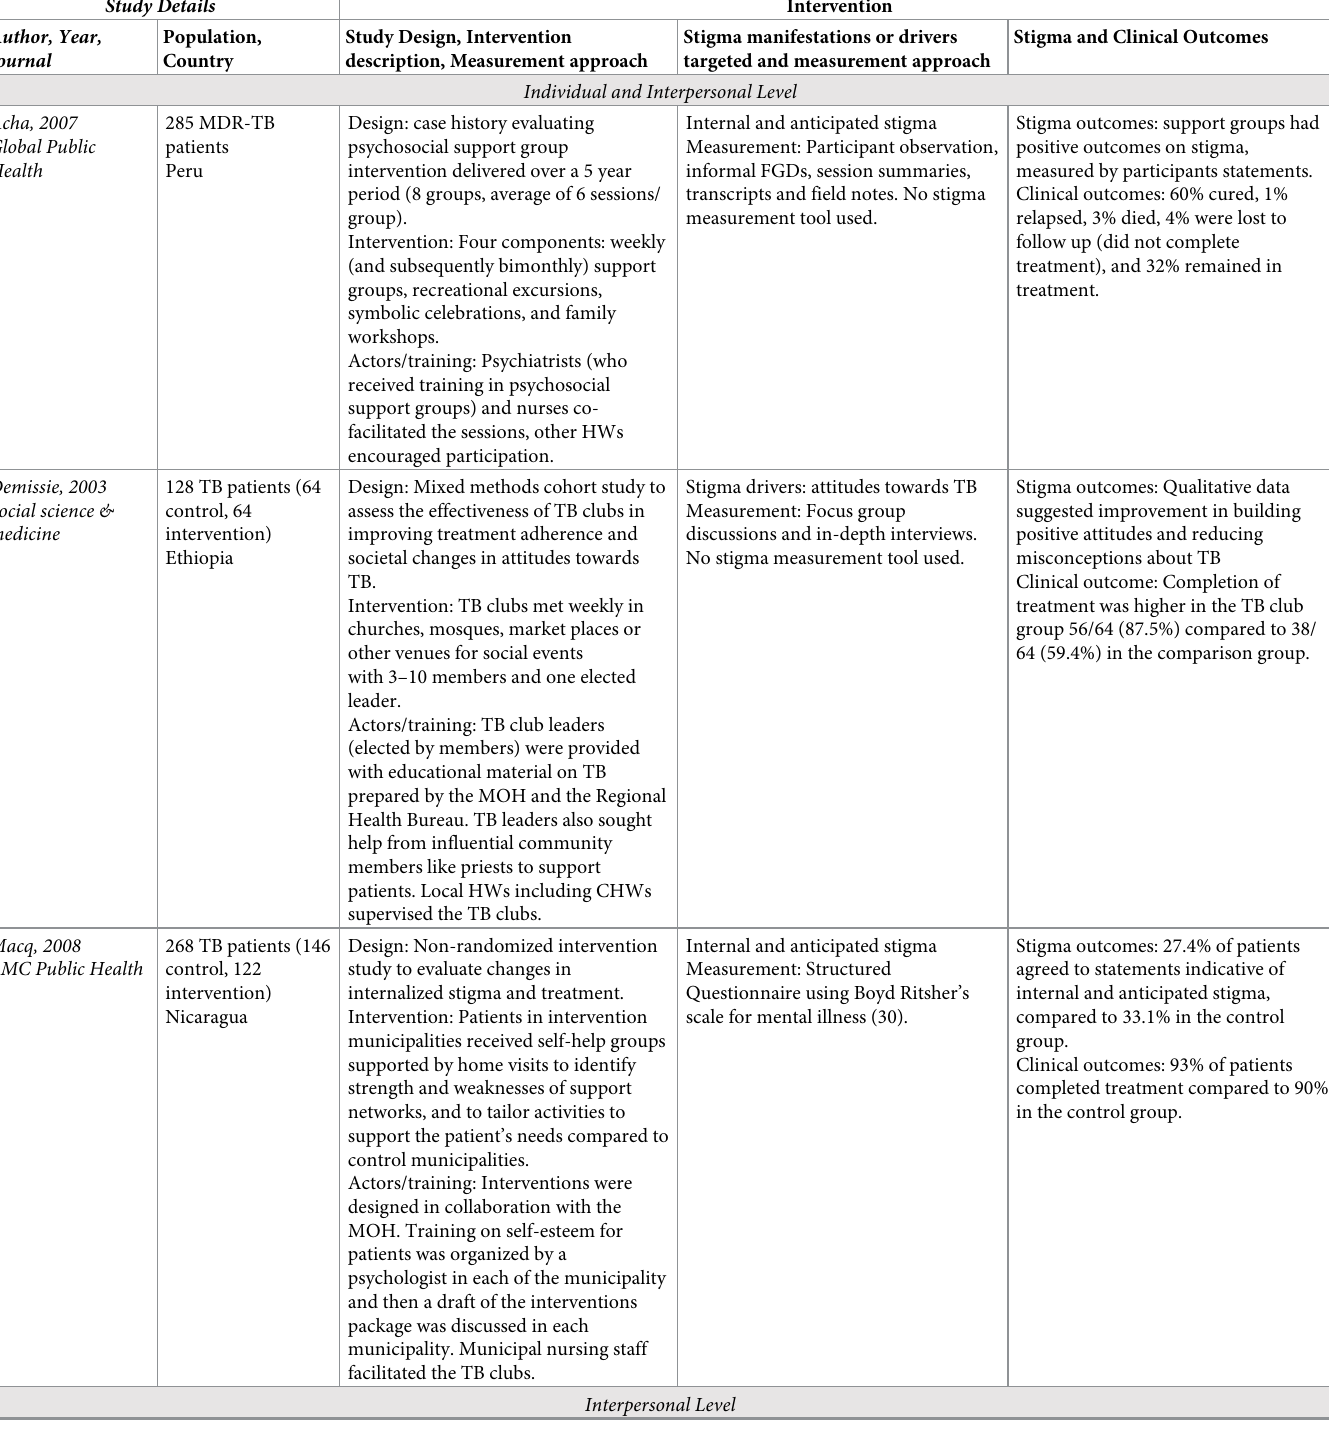
Table 1. Characteristics of included studies, organized by socio-ecological